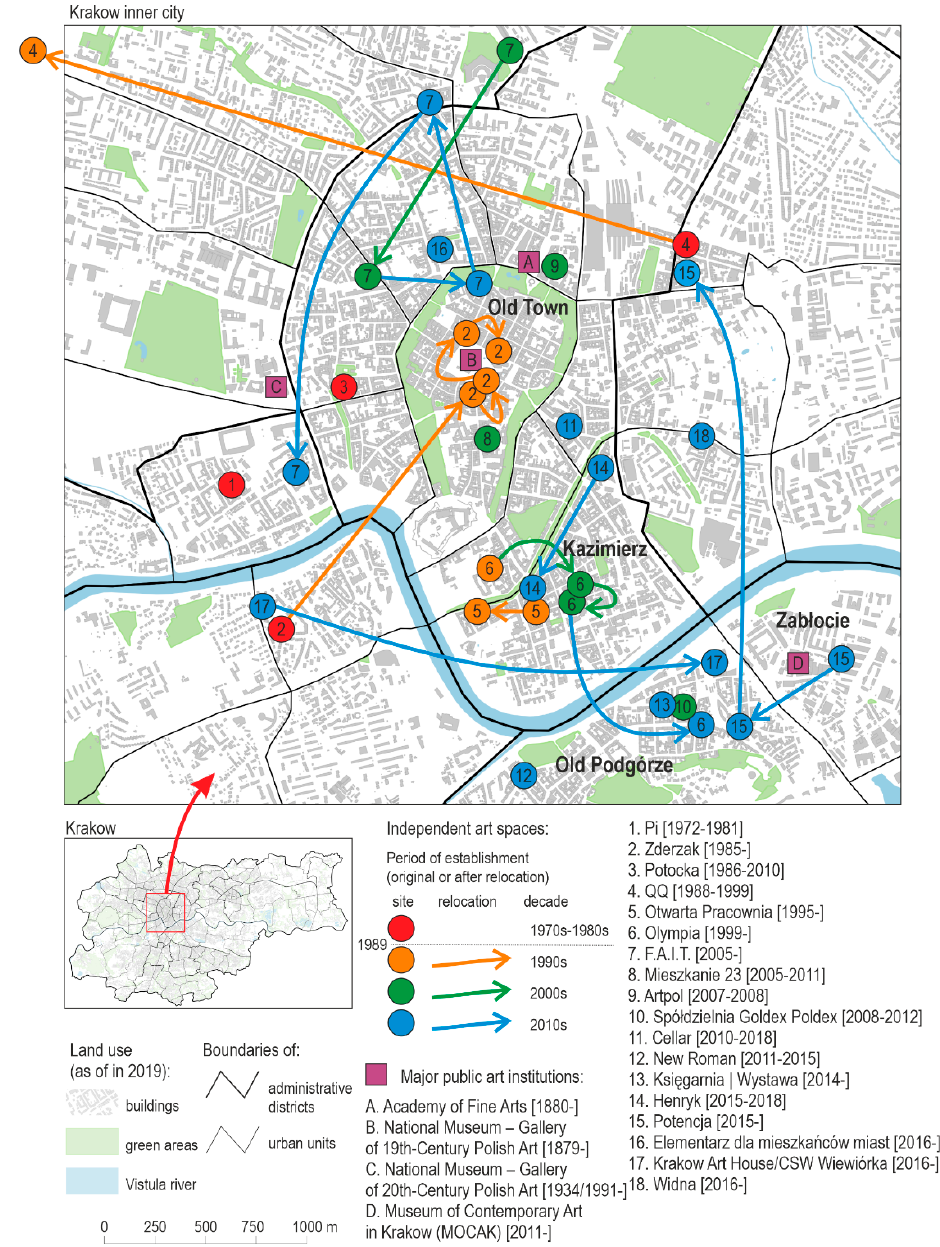
Figure 1. Locations and relocations of independent art spaces in Krakow’s inner city. Source: own study.